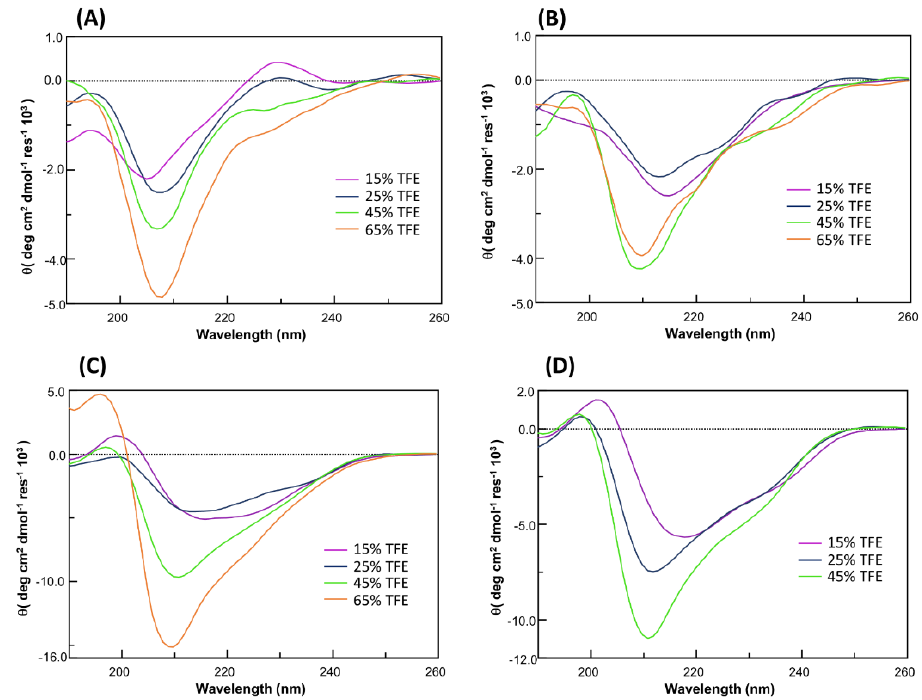
Figure 2. CD spectra of: ( A ) KIRCONG amide; ( B ) KIRCONG disulfide; ( C ) KIRCONG i/i+5; ( D ) KIRCONG i/i+7 in TFE/buffer 15-65% v / v . KIRCONG i/i+7 resulted not soluble in 65/25 v / v , TFE/buffer and the related spectrum is